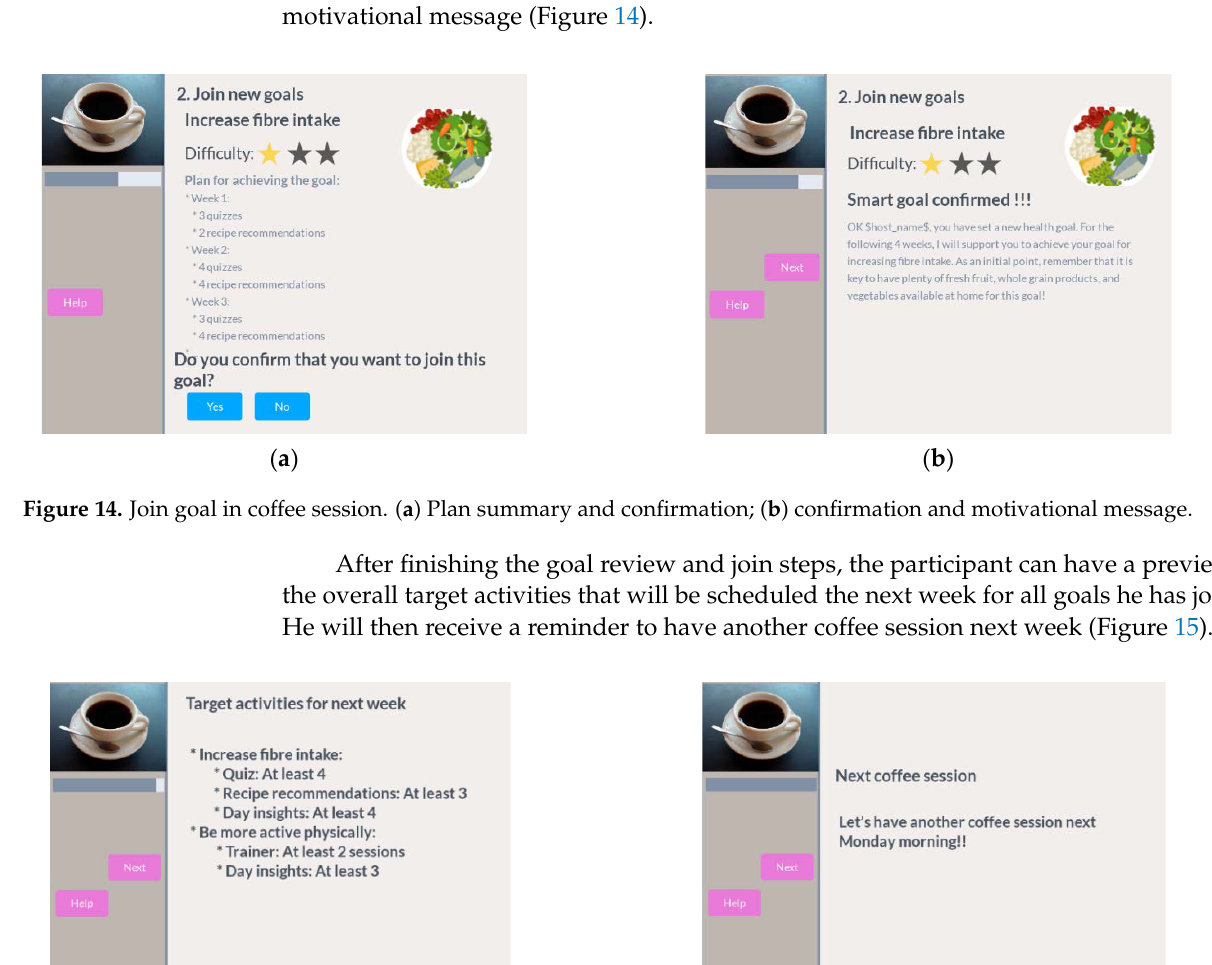
Figure 13. Join goal in coffee session. ( a ) Goal description and requirements; ( b ) set goal difficulty.